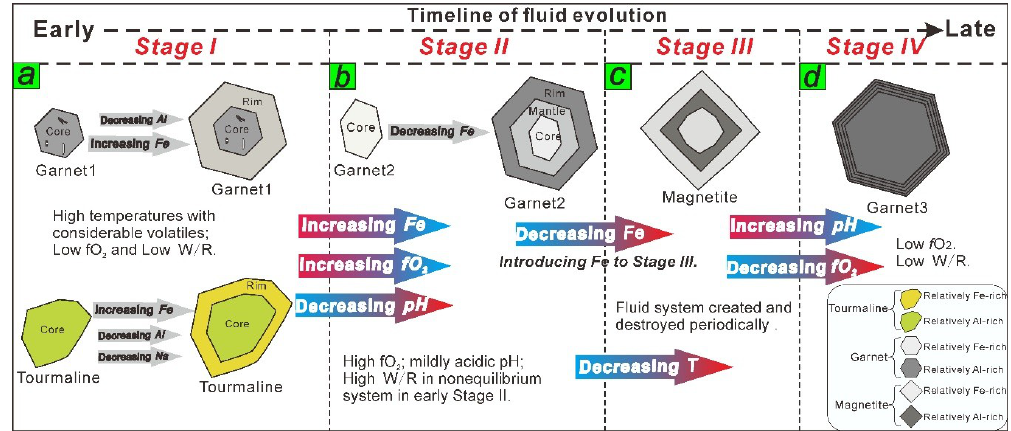
Figure 16. Schematic timeline of fluid evolution model for the Yamansu deposit. ( a ) Ore-forming fluid in Stage I was characterized by high temperatures with considerable volatiles, low f O 2 and